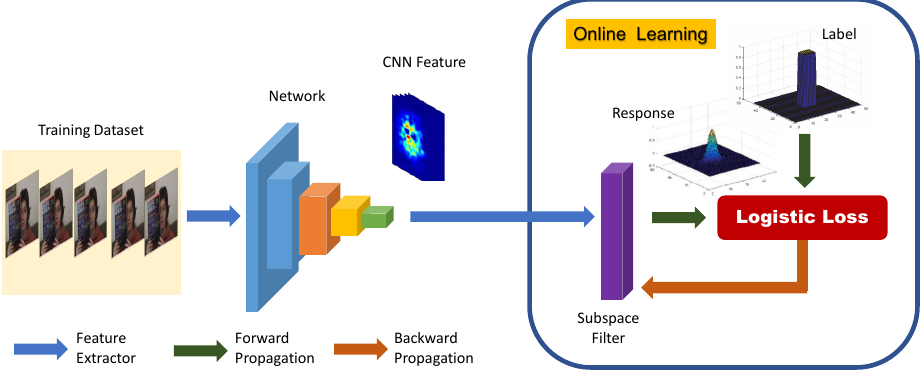
Figure 3. Online learning of semantic subspace filter. The training data are fed into the network to extract the CNN feature for the high-level semantics of the target. These features are then used as the input of the subspace filter that is trained under the supervised signal (e.g., the label) online. The logistic loss is employed as the last layer of the network to make the generated response close to the expected one, which benefits identification of the target from the background. The blue, green, and orange lines represent feature extraction, forward propagation, and backward propagation,